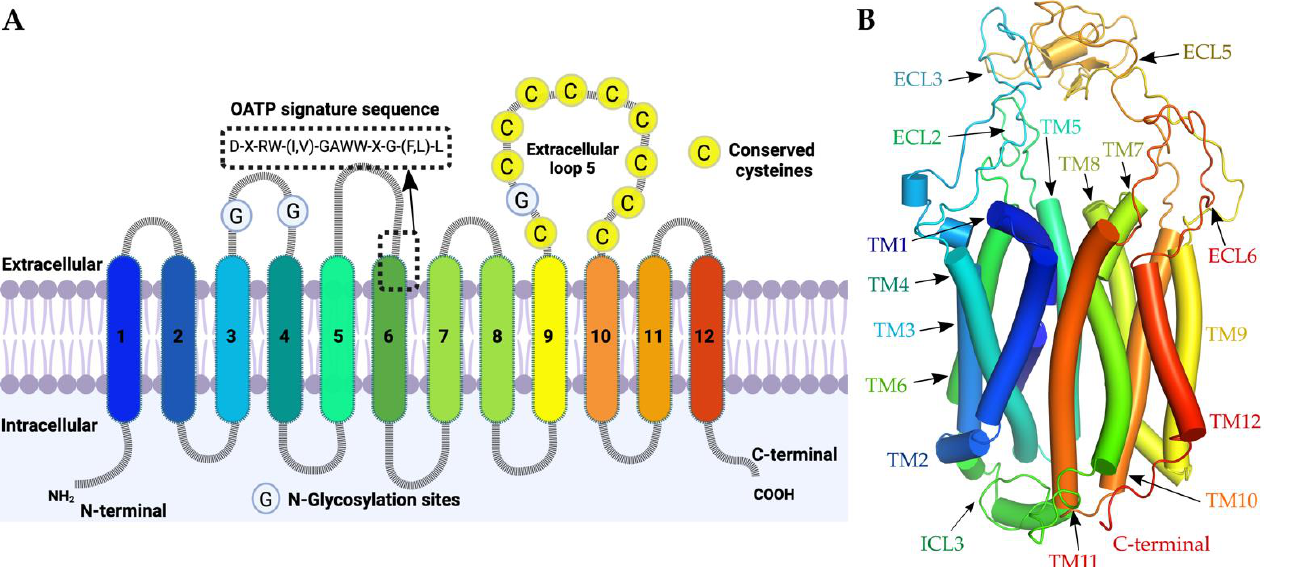
Figure 1. ( A ) 2D structure representation of the compounds OATP ligands employed in this study, negatively charged anions are highlighted in yellow. ( B ) Overall study design and workflow fol- lowed.